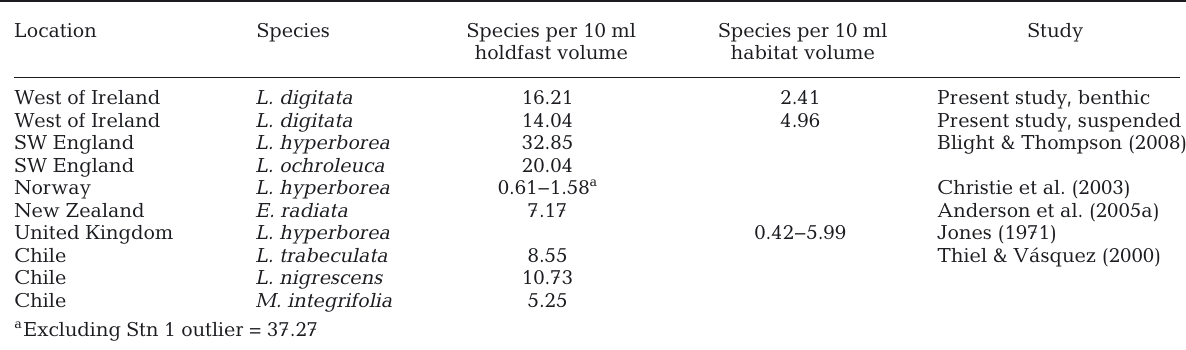
Table 5. Comparison of mean species per 10 ml of holdfast volume or habitat volume across a number of studies from varying locations and varying kelp species ( L .: Laminaria , E .: Ecklonia , M .: Macrocystis ). Range values given when differential samples from species, location and other factors were